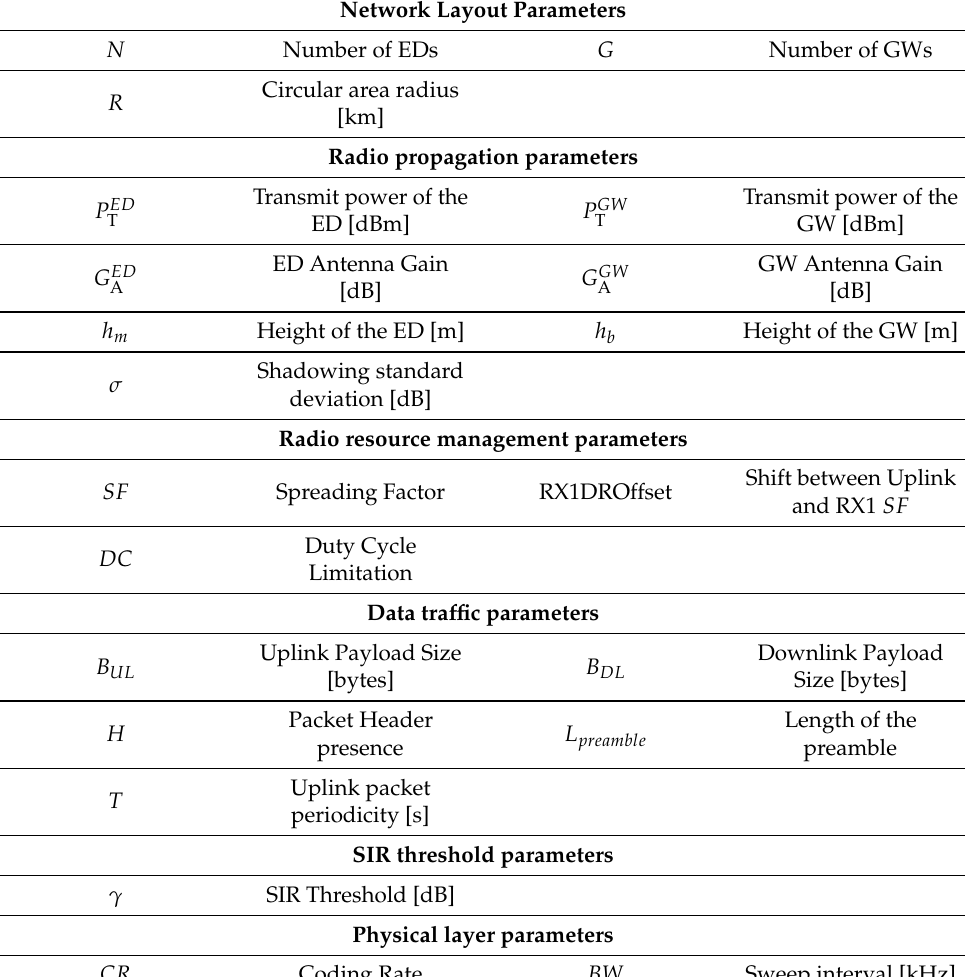
Table 5. List of parameters defined by the